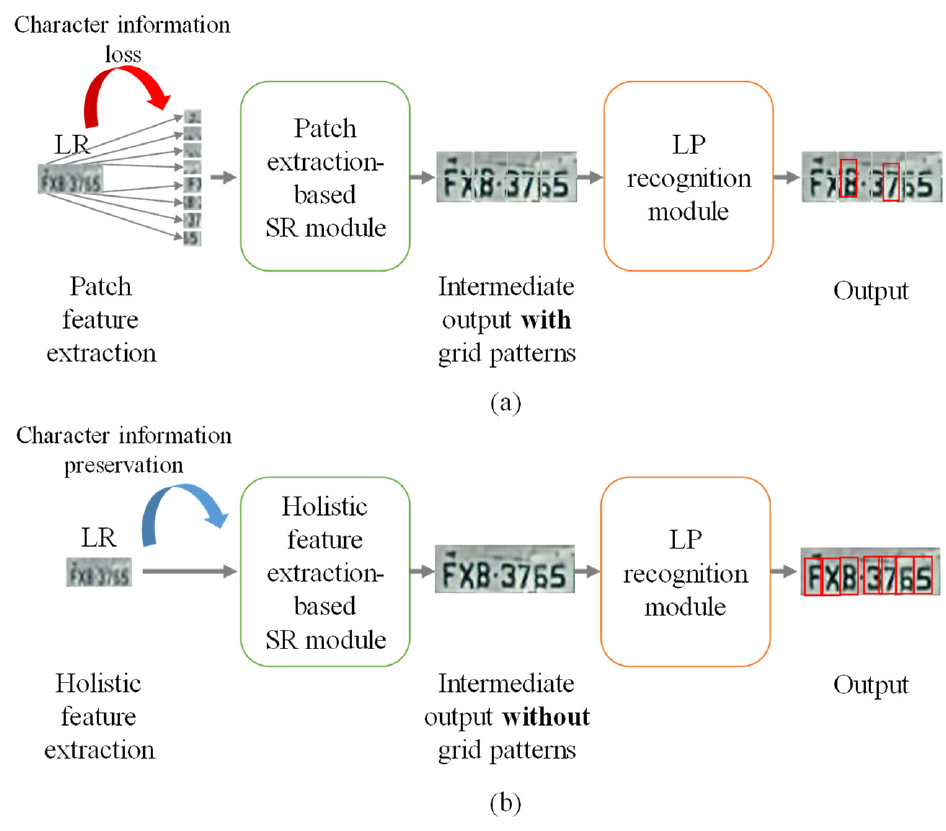
Figure 3. ( a ) Diagram of the patch-based end-to-end training process. ( b ) Diagram of the holistic- feature-based end-to-end training process. In output images, red boxes denote the detected character region.